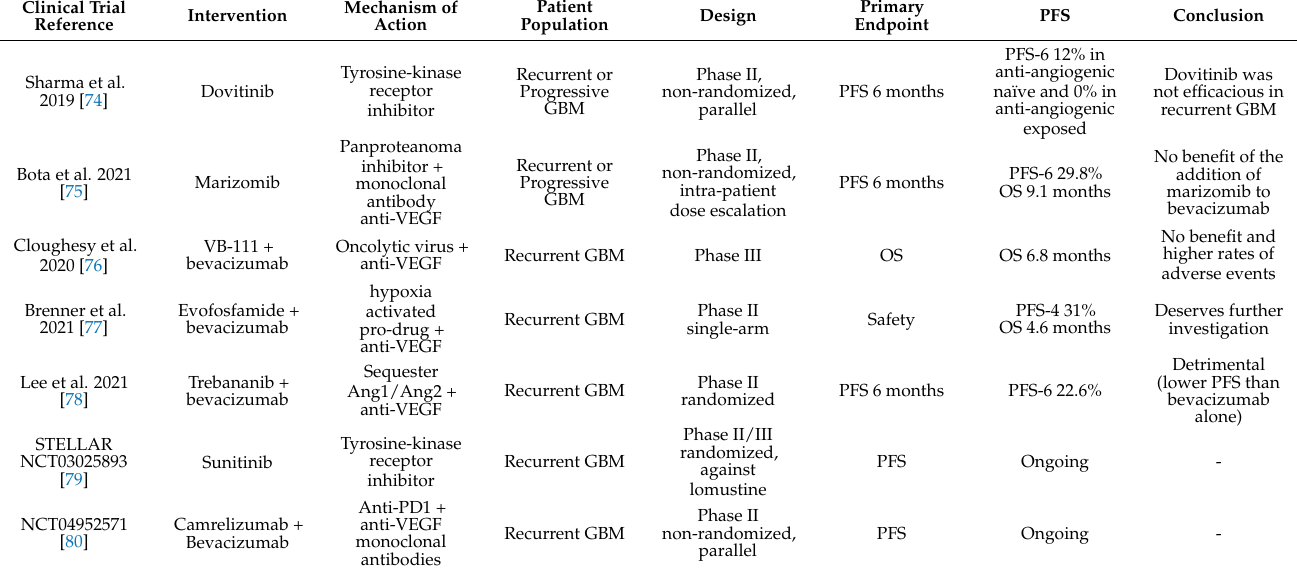
Table 1. Selected phase II and III, finished or ongoing, clinical trials of anti-angiogenic therapy in glioblastoma, alone or in combination with other